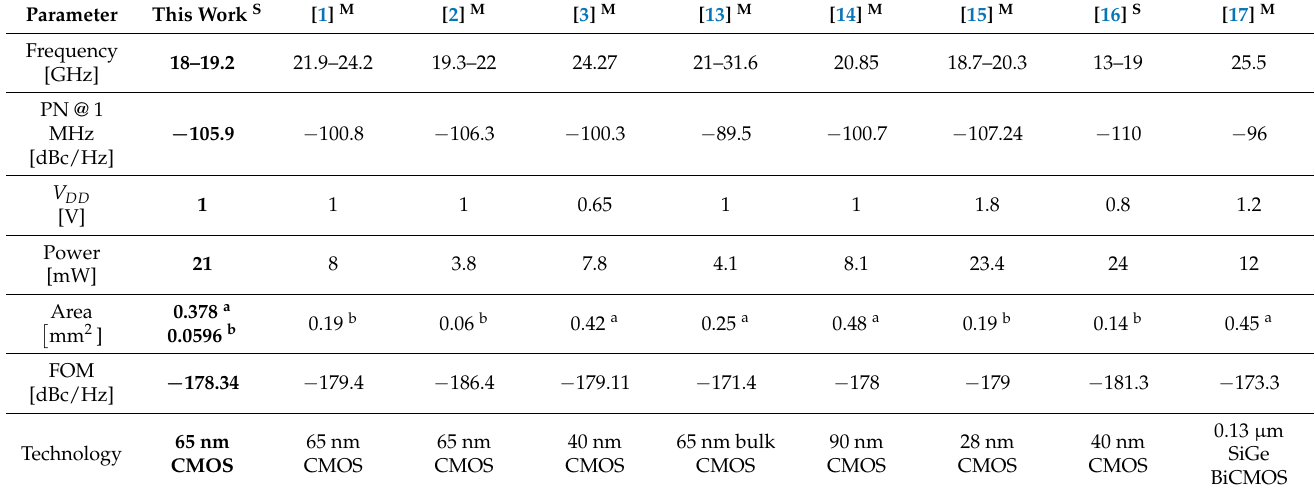
Table 2. Performance comparison